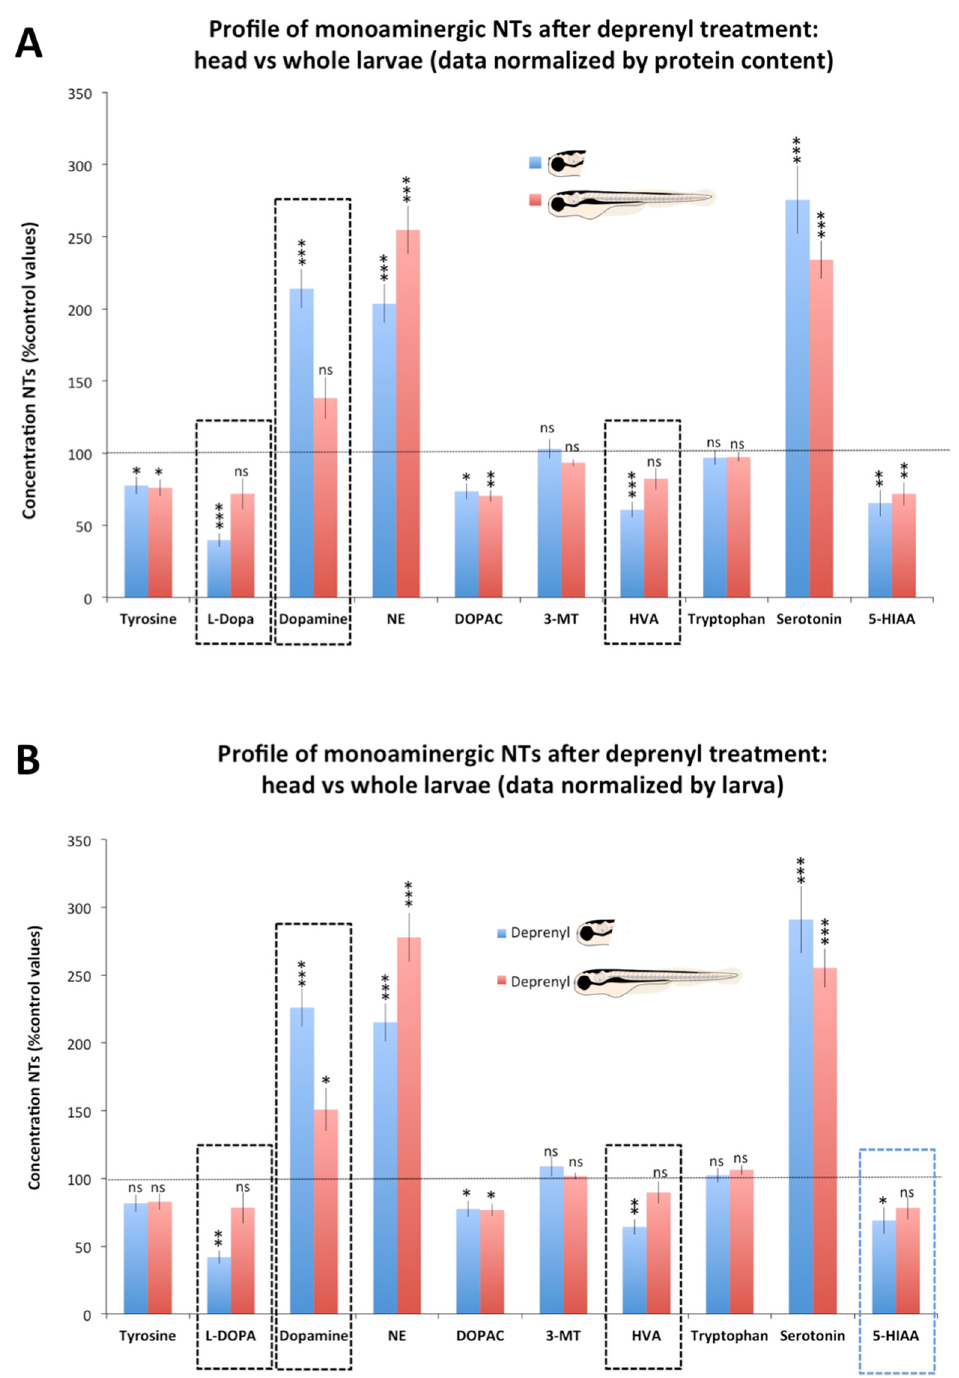
Figure 3. Profile of monoaminergic neurochemicals after deprenyl treatment: head vs. whole body. Concentrations are presented as percentage of the control values. ( A ) Data normalized by protein content; ( B ) Data normalized by larva. Student’s t -test (n = 8 pools); ns: non-significant, * p < 0.05, ** p < 0.01, *** p < 0.001; Data from 2 independent experiments.